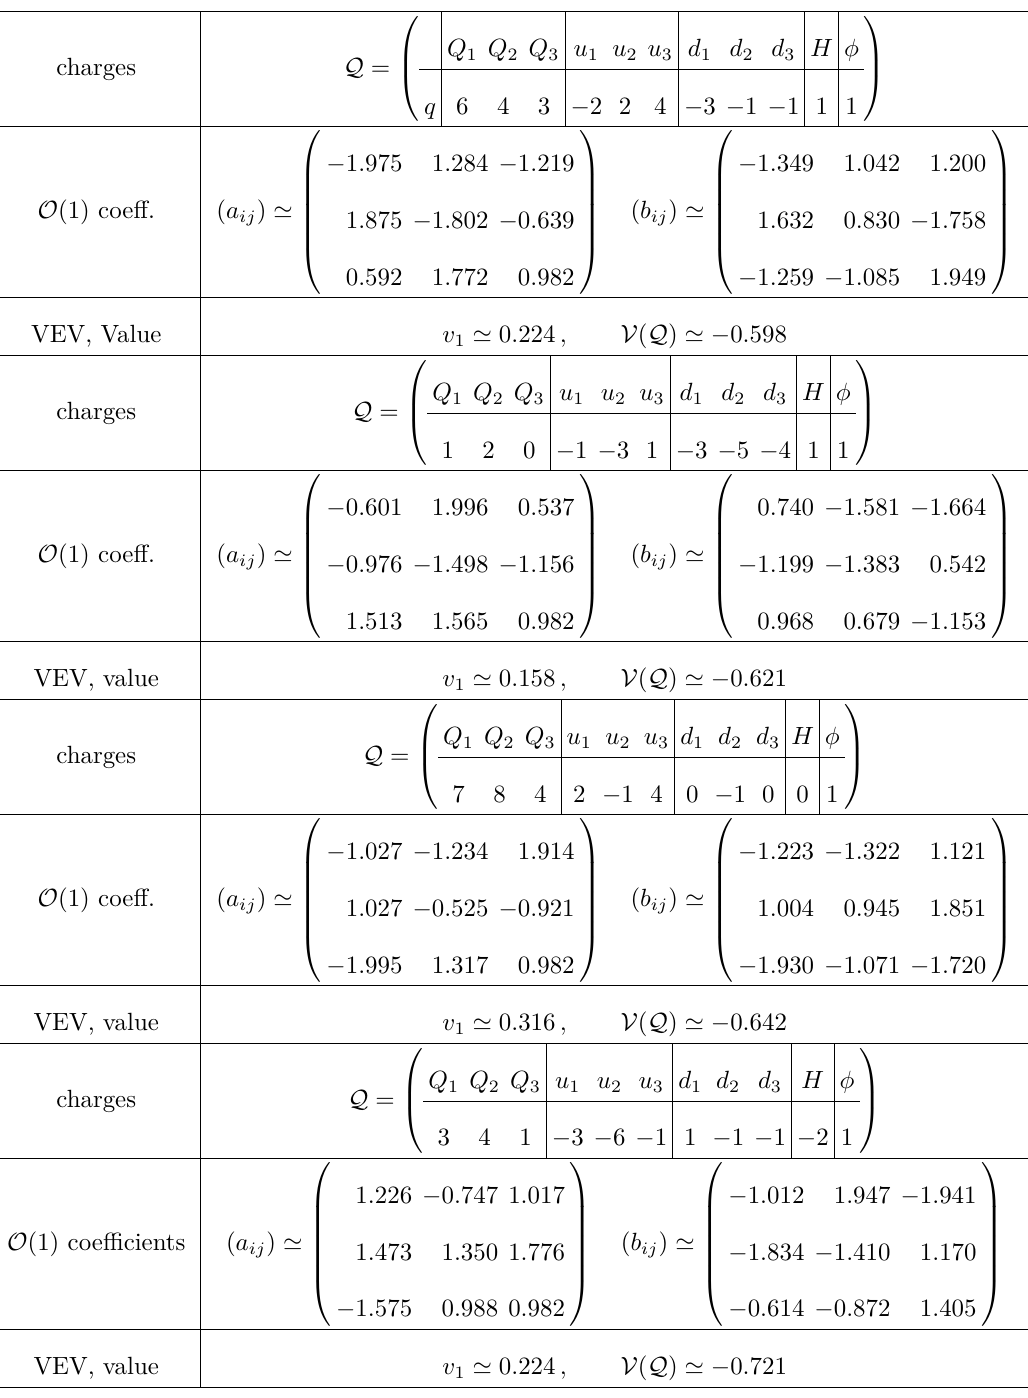
Table 2. Models with high intrinsic value for a single U(1)